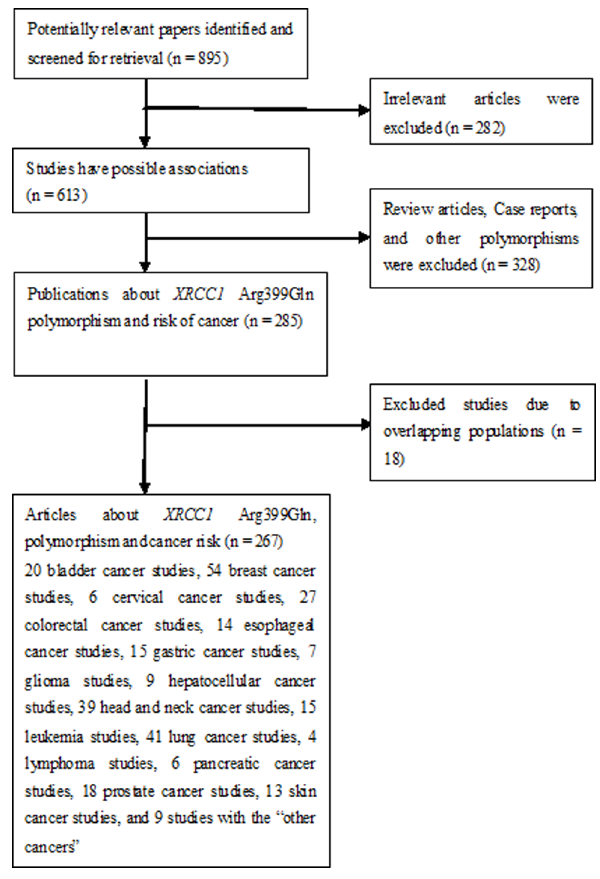
Figure 1. Study flow chart explaining the selection of the 297 eligible case–control studies included in the meta-analysis.